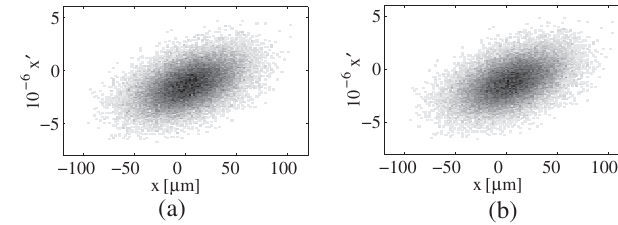
FIG. 6. Horizontal phase space distributions behind a symmet- ric C-chicane obtained with the one-dimensional method (a) and the two-dimensional method (b). The corresponding normalized emittances are 587 : 2 nm rad and 586 : 3 nm rad ,